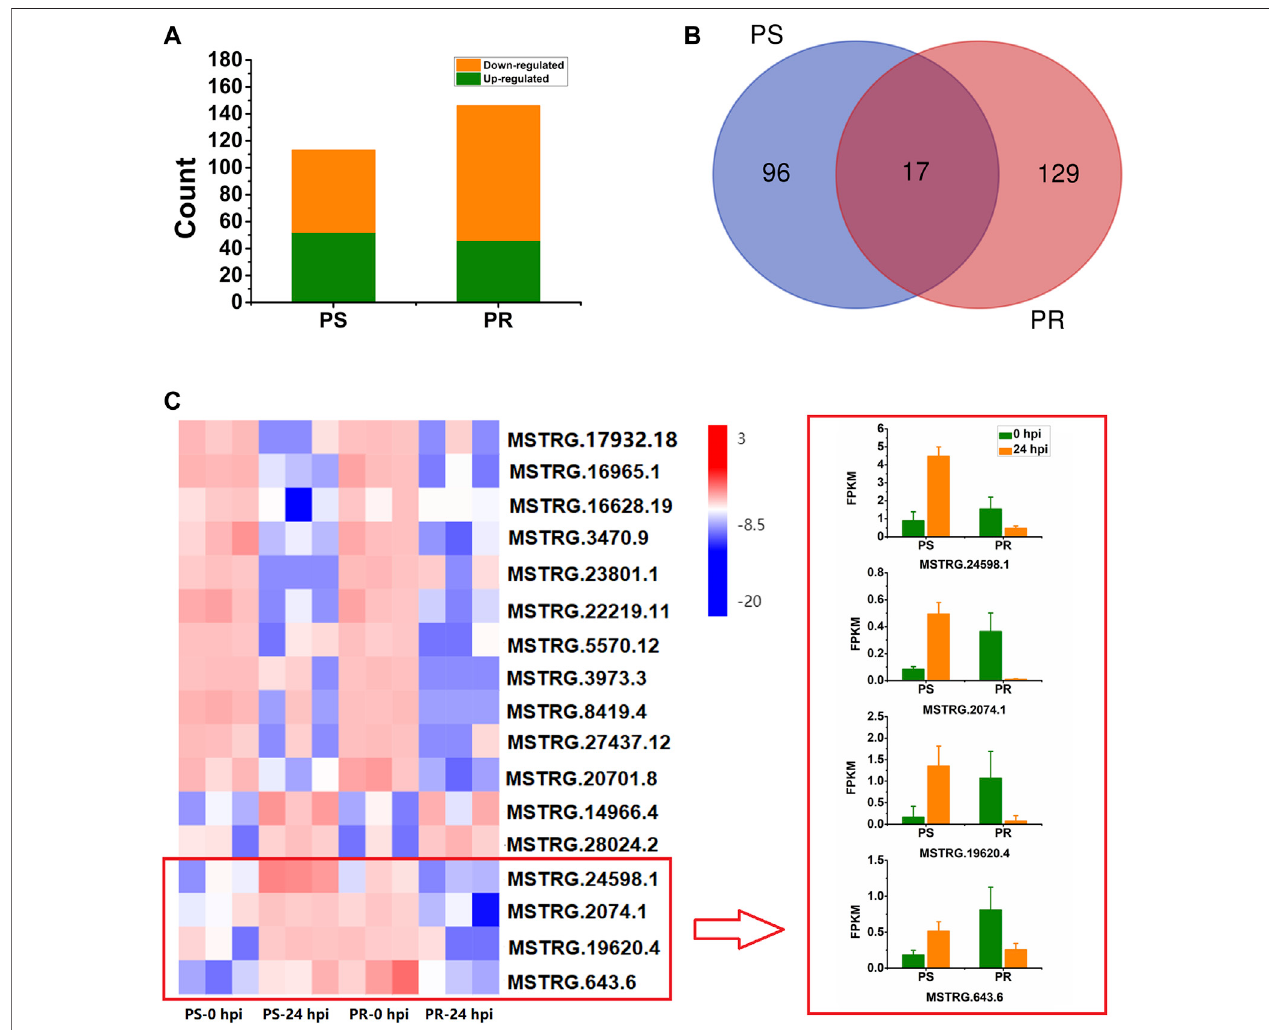
FIGURE 3 | Statistical analysis and expression of PM-responsive lncRNAs in PM-susceptible and PM-resistant C. pepo . (A) Number of down- and up-regulated lncRNAs at 24hpi inPSand PR. (B) Numberofshared and speci fi cPM-responsivelncRNAs in PSand PR. (C) Expressionofthe17PM-responsive lncRNAs shared by PS and PR. Four of them showed inconsistent expression patterns between PS and PR. PS represents PM-susceptible C. pepo and PR represents PM-resistant C. pepo . Error bars indicate standard deviations among three biological replicates ( n = 3).